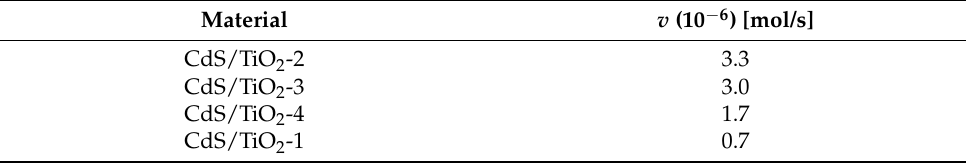
Table 2. Rate values ( v ) after 30 min of irradiation of each CdS/TiO 2